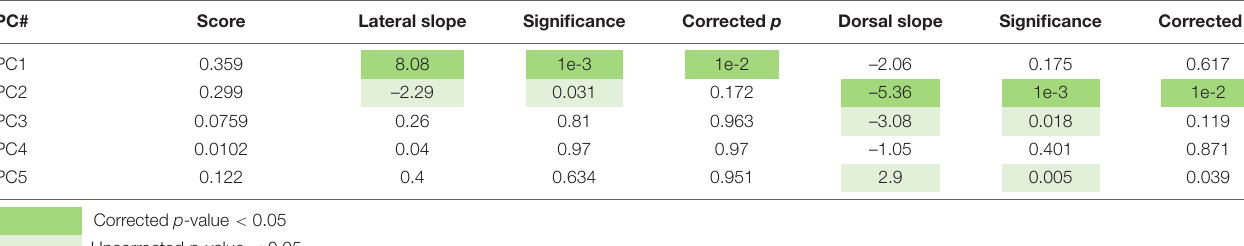
FIGURE 3 | Spatial location of targeted cells in the VTA influences both inputs and outputs. (A) Context for coronal slice of VTA used in analysis is shown. (B) Brains are plotted by starter cell center of mass (COM), colored by PC1 value. (C) Brains are plotted by starter cell COM, colored by PC2 value. (D) Brains are plotted by starter cell COM, colored by PC3 value. (E) Brains are plotted by starter cell COM, colored by PC4 value. (F) Brains are plotted by starter cell COM, colored by projection specification. Ellipsoids are drawn for each condition and have radii of five standard deviations for both dorsoventral and lateromedial axes. (G) Z-scores of average input and output counts for each projection condition. Inputs are marked with a green down arrow and outputs with a red up arrow. All inputs and outputs quantified are shown. Inputs and outputs are sorted according to the projection in which they receive the highest z-score. Samples include inputs to and outputs from DA cells only. p -values are listed in Table 2 . TABLE 1 | Linear regression scores predicting starter cell location from principal